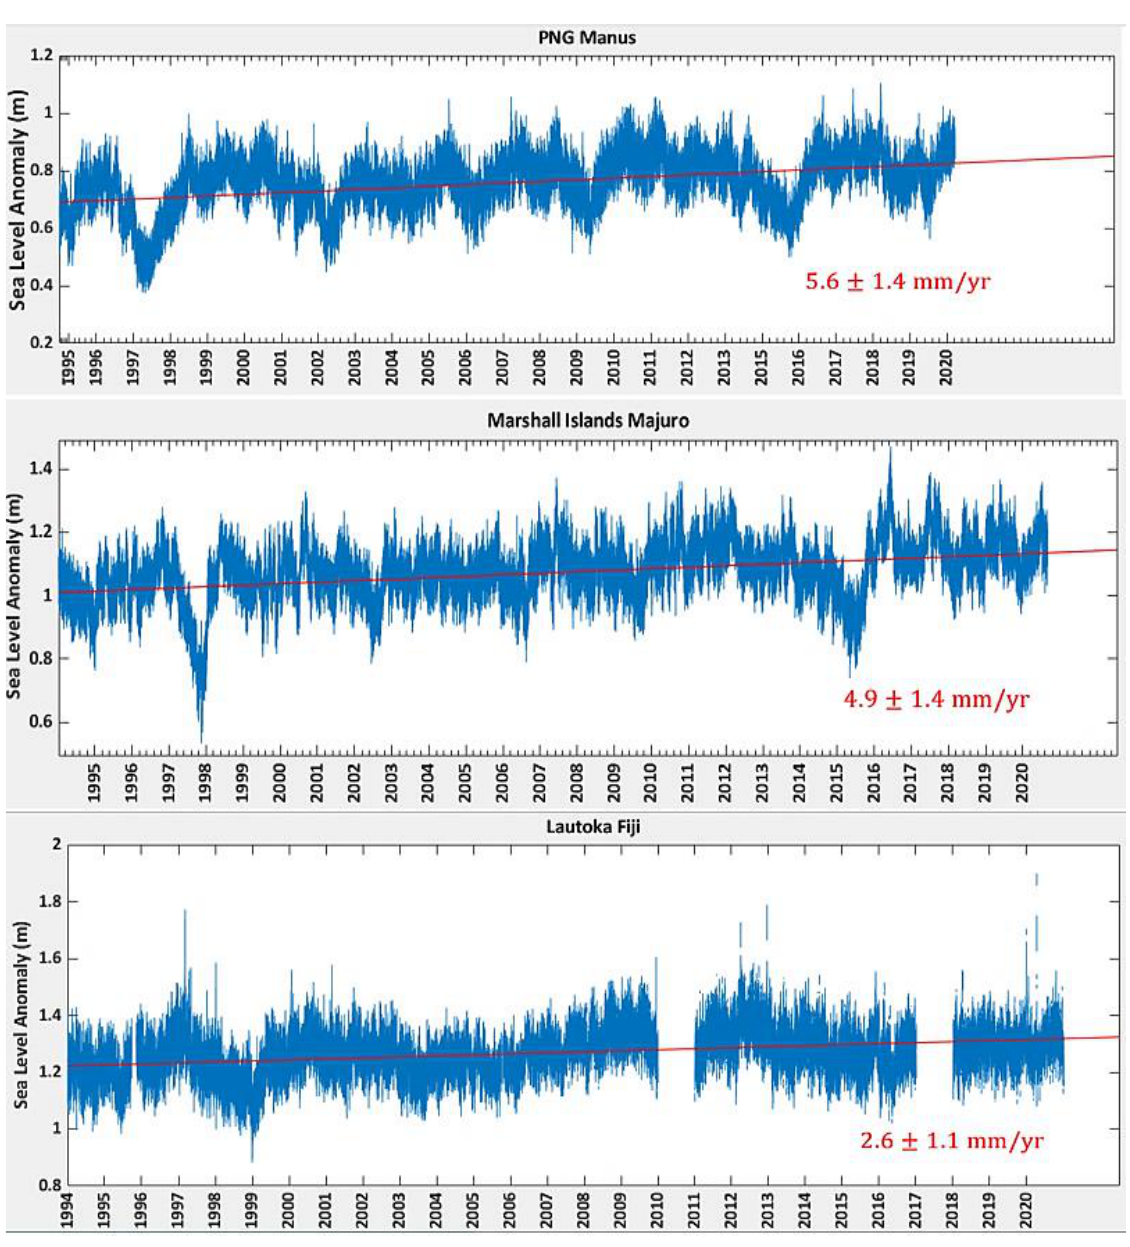
Figure 8. The graphs show the mean sea level trend and computed rise per year for the period 1994 – 2020.